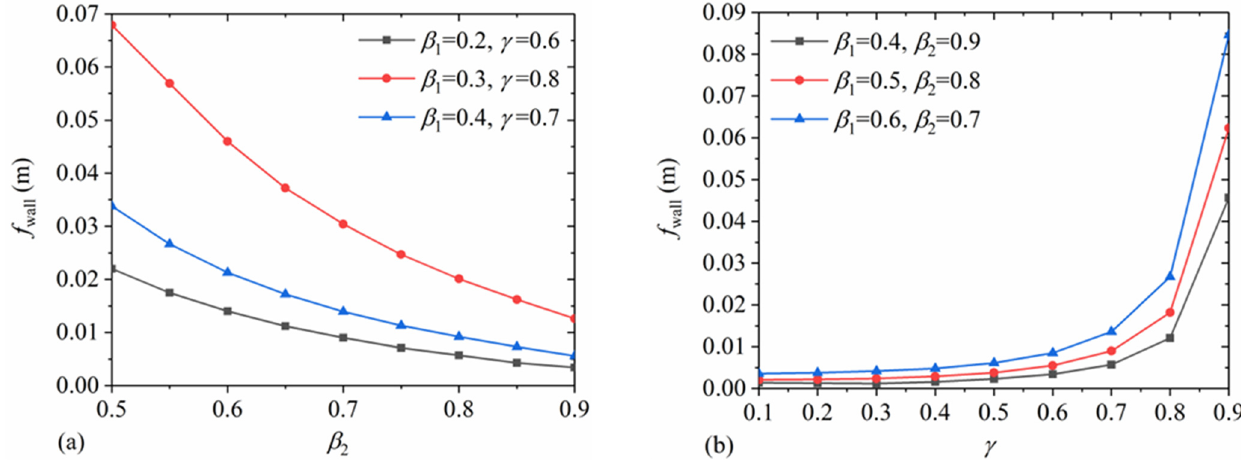
Figure 10. Amplitudes for the surface height at the tank wall f max : ( a ) under the upper baffle height β 2 ; ( b ) under the baffle inner radiuses γ 2